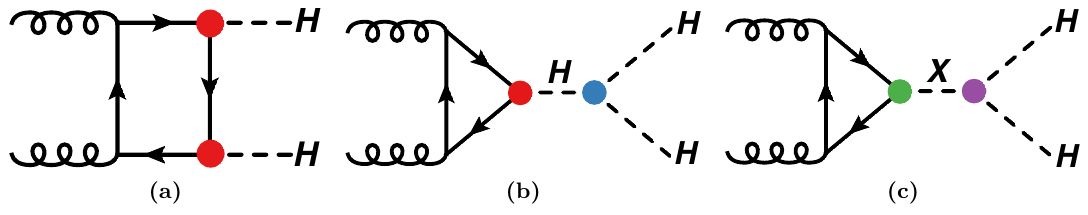
Figure 1. Leading-order production modes for Higgs boson pairs. In the SM, there is destructive interference between (a) the heavy-quark loop and (b) the Higgs self-coupling production modes, which reduces the overall cross-section. BSM Higgs boson pair production could proceed through changes to the Higgs couplings, for example the t (cid:22) tH or HHH couplings which contribute to (a) and (b), or through an intermediate resonance, X , which could, for example, be produced through a quark loop as shown in